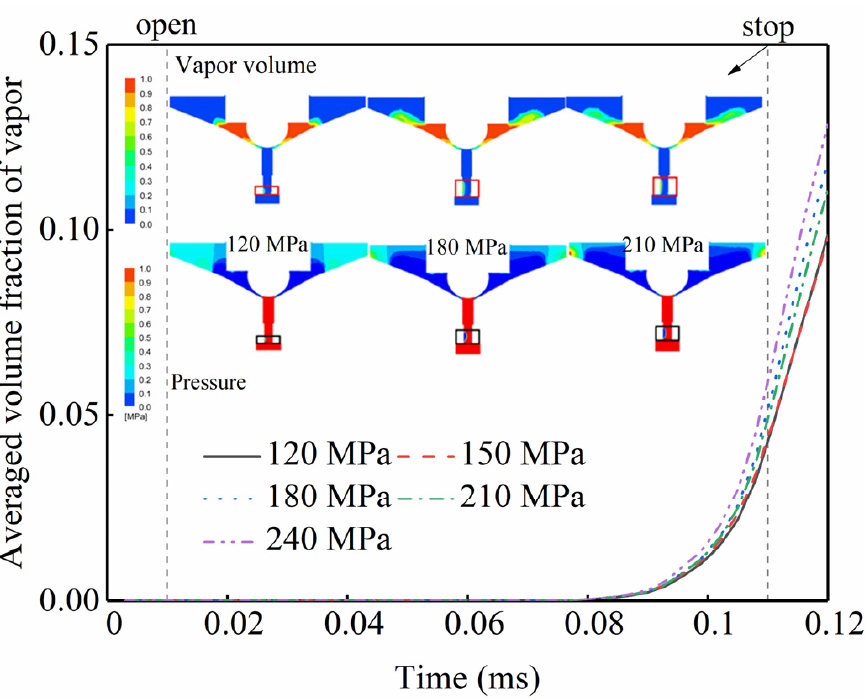
Figure 13. Pressure and gas phase volume distribution in the outlet throttle when the spherical valve is fully open.